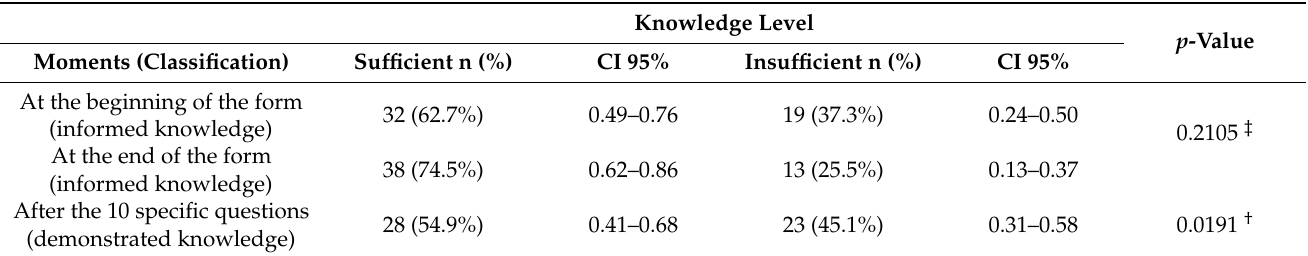
Table 3. Variation in the knowledge of dentists in the Brazilian state of Par á with regard to the oral care needs of